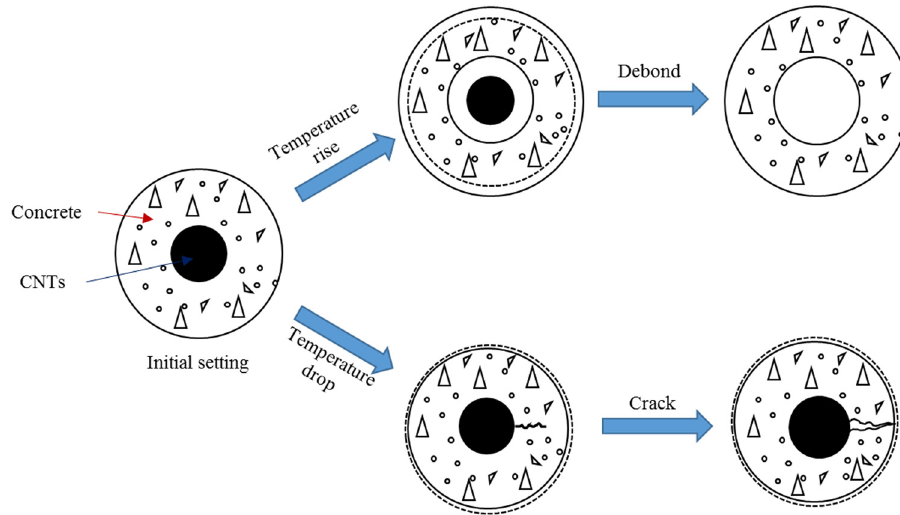
Figure 12: E ff ect of temperature change on the NC ( the dashed line shows the initial position of the matrix before deformation )